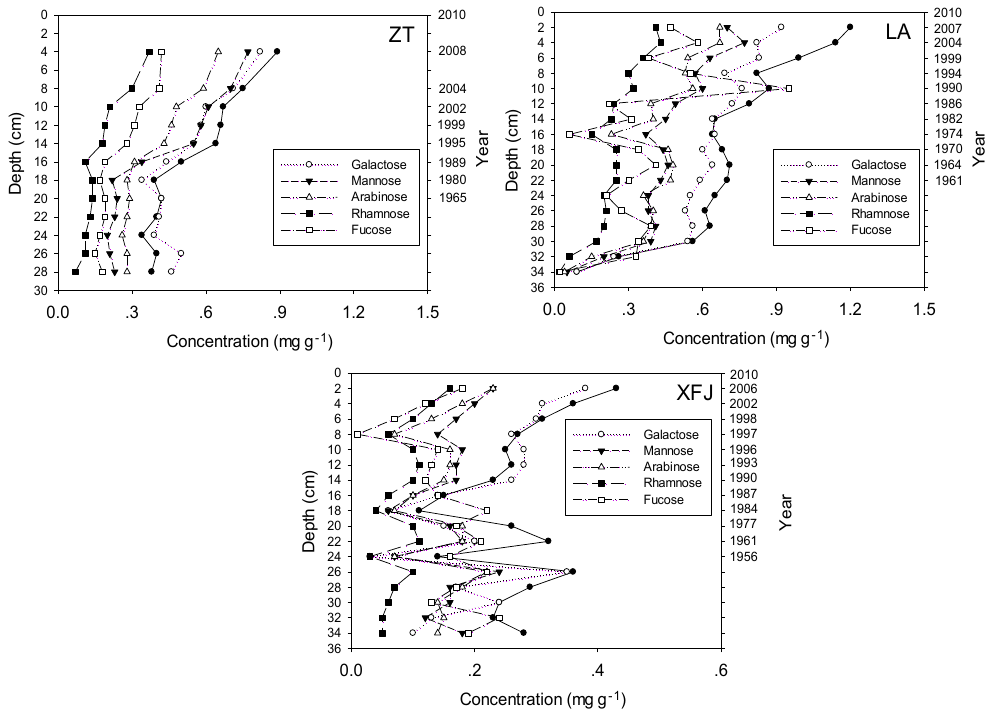
Figure 2. Profiles of neutral carbohydrates in sediment cores of the